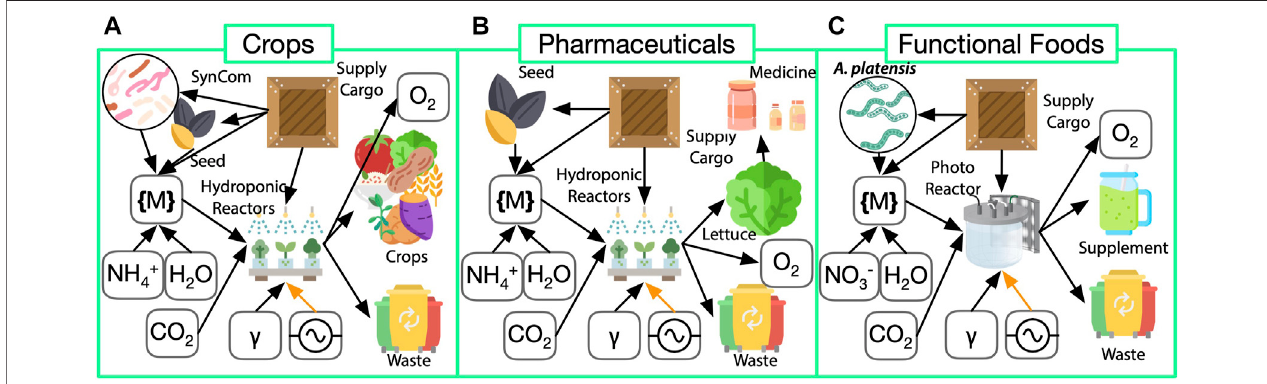
FIGURE3| FPS(greenin Figure2 )systembreakdownforbiomanufactoryelementsof (A) crops, (B) abiopharmaceutical,and (C) functionalfoodproduction.Inall cases, growth reactors require power (electrical current symbol ) and light ( γ ). (A) Crop biomass and oxygen gas (O 2 ) are produced from hydroponically grown plants using seeds and the set of media elements ({M}) derived from supply cargo. The reactor is also supplied with an ammonium (NH + 4 ) nitrogen source and CO 2 carbon source from ISRU processes. (B) In a similar fashion, medicine can be produced from genetically modi fi ed crops such as lettuce (C) Functional foods such as nutritional supplements areproduced via autotrophic growth of Arthrospira platensis . Inall cases, biomass isproduced,collected,and inedible biomass isdistributedto the LC module for recycling. Orange lines indicate additional power supply to the system.